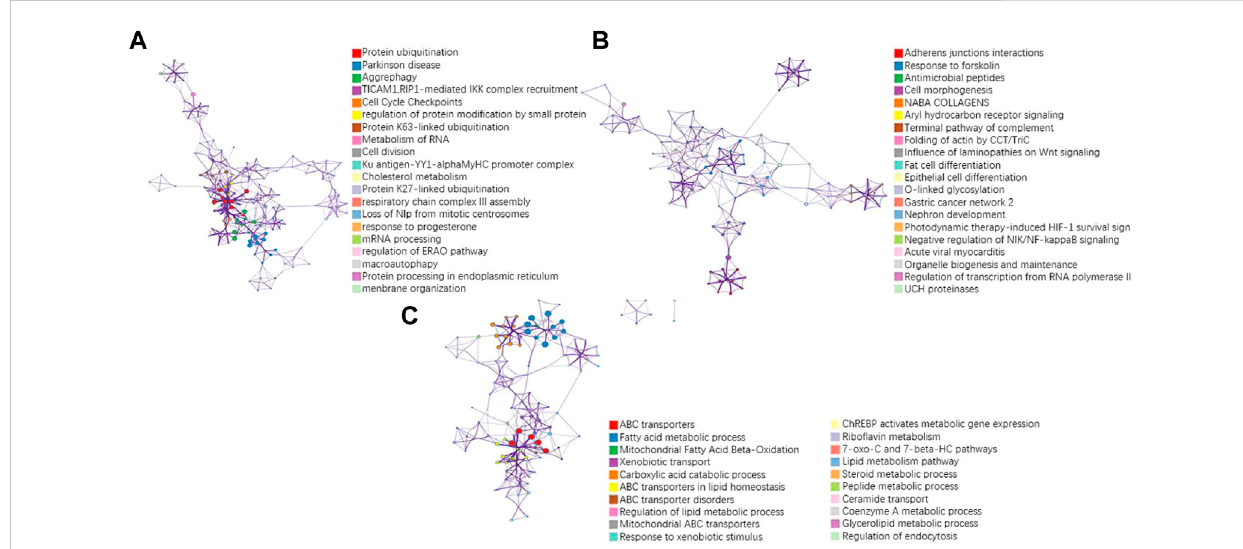
FIGURE 9 ResultsofpathwayenrichmentanalysisofthedrugAlectinib. (A) pathwayresultsforthe fi rstPCofseqomicsdata; (B) pathwayresultsforthe fi rstPC of CNA omics data; (C) pathway results for the fi rst PC of methylation omics data.